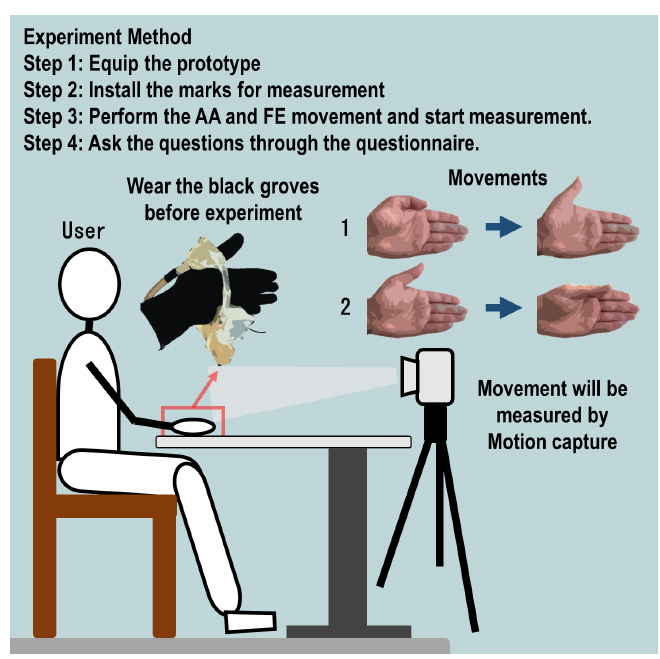
Figure 20. Concept of the experimental